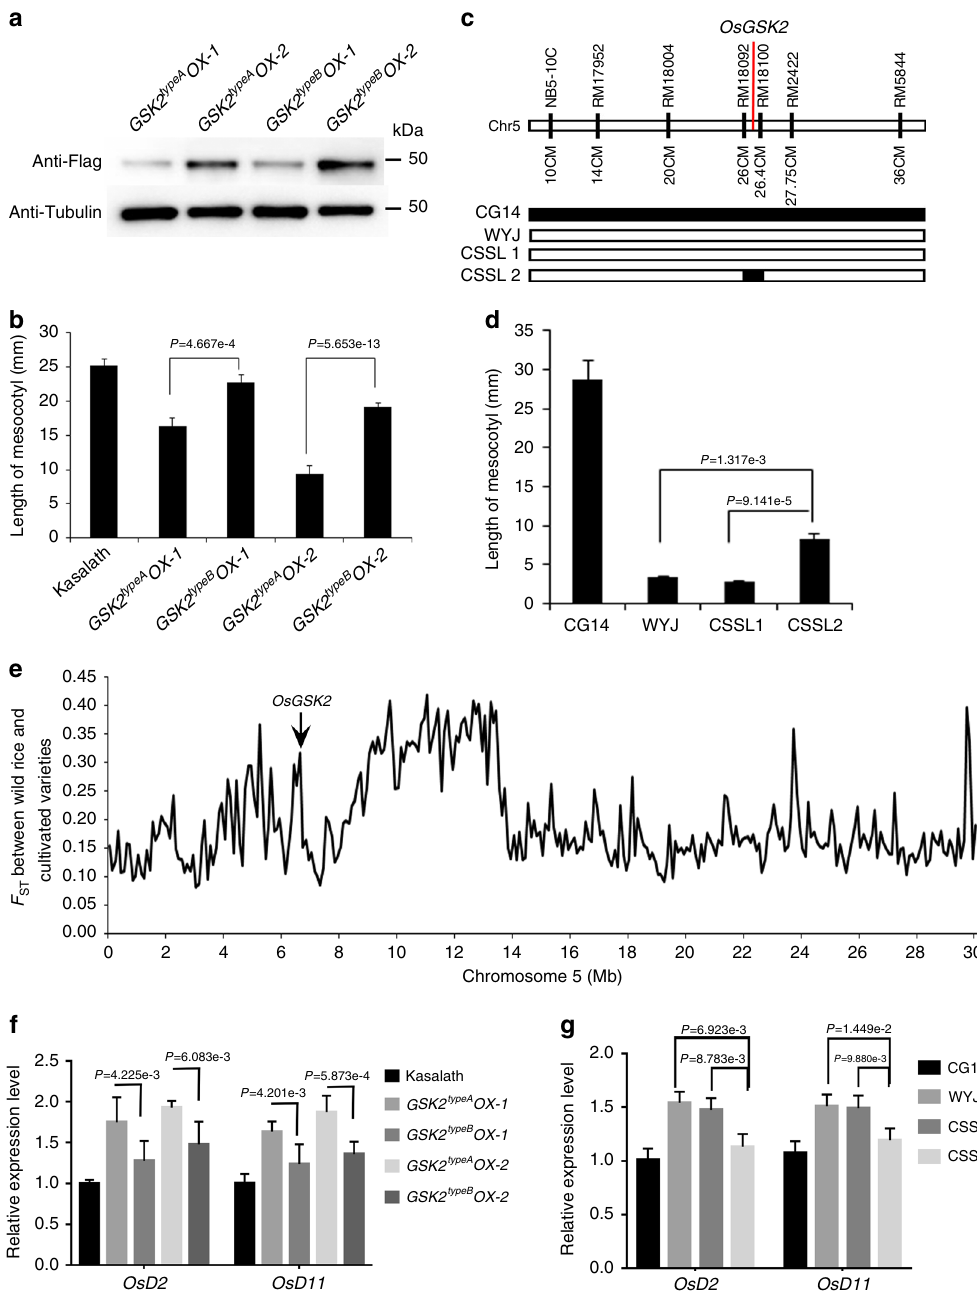
Fig. 2 The natural alleles of OsGSK2 function in mesocotyl length and BR signaling. a The protein levels of OsGSK2 typeA -FLAG and OsGSK2 typeB -FLAG in the independent transgenic rice in Kasalath background. b Mesocotyl length of OsGSK2 typeA and OsGSK2 typeB transgenic rice in a . Kasalath is the background. Error bars are SE ( n = 30). P value is determined by Welch ’ s t test with Bonferroni correction. c Graphical genotypes of the chromosome segment substitution lines used in this study. WYJ is the recurrent parent and CG14 is the donor parent. CSSL1 and CSSL2 are two substitution lines. CSSL1 is a control segregated from the CSSLs population. d The mesocotyl length of the CSSLs and their parents indicated in c . Error bars are SE ( n = 25). P value is determined by Welch ’ s t test with Bonferroni correction. e The level of genetic differentiation ( F ST ) across chromosome 5 between the Oryza ru fi pogon and cultivated rice. The F ST level of OsGSK2 locus is 0.316, and the average F ST level in the whole genome is 0.172. f – g The relative transcript levels of OsD2 and OsD11 in OsGSK2 transgenic lines from a and in the CSSLs from c . Total RNAs were extracted from the mesocotyls. The transcript level in WT was de fi ned as “ 1 ” . Data are means± SD ( n = 3). P value is determined by Welch ’ s t test with Bonferroni